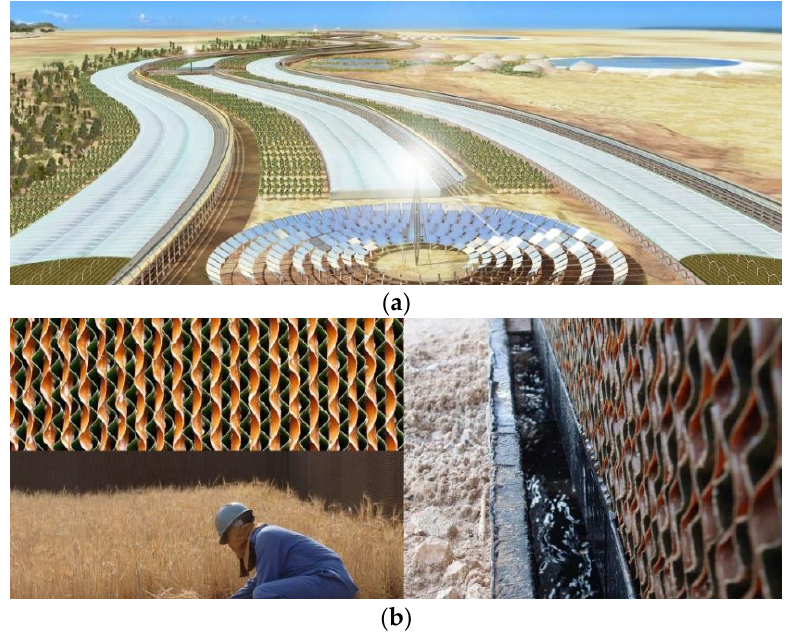
Figure 7. Sahara forest project inspired by natural ecosystem: ( a ) Sahara forest project in Tunisia; ( b ) Food, re-vegetation and salt water system. Images ( a , b ): reprinted with permission from ref. [100]. Copyright 2020 © Exploration Architecture.